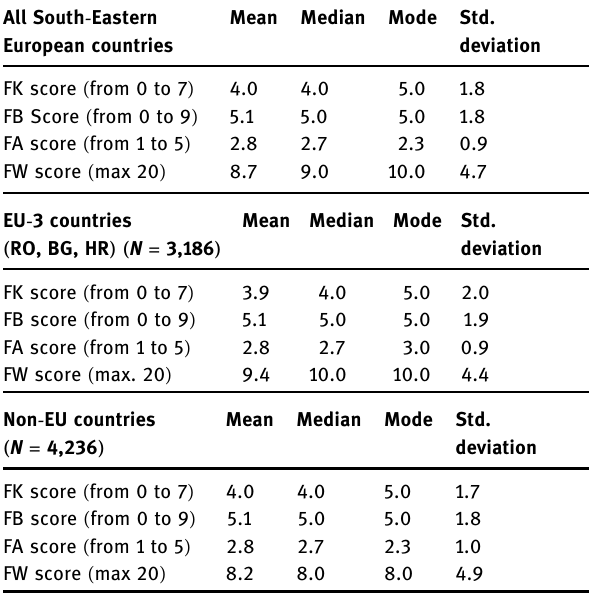
Table 2: Descriptive statistics for FL and